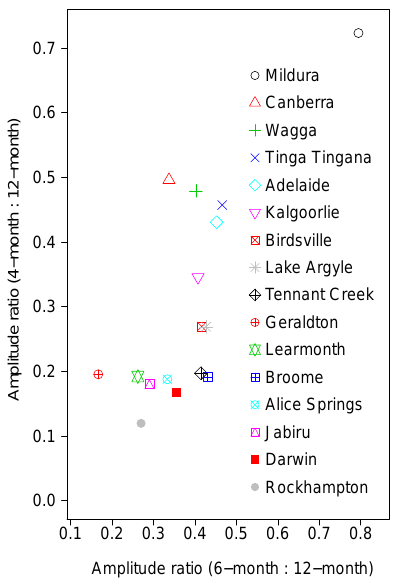
Figure 9. The standard deviation of the episodic component of the aerosol optical depth expressed as a fraction of the amplitude of the periodic aerosol optical depth at 500nm, plotted against the amplitude of the periodic aerosol optical depth at 500nm. This al- lows clear separation between (a) the tropical stations, and (b) sta- tions effected by increasingly large episodic activity. Stations where the episodic standard deviation is more than 30% of the periodic component include the smoke-affected temperate stations of Wagga Wagga and Canberra, and the dust-dominated station at Tinga Tin- gana. The high episodic aerosol at Wagga Wagga and Canberra is consistent with the increasing incidence of smoke aerosol from forested areas from west to